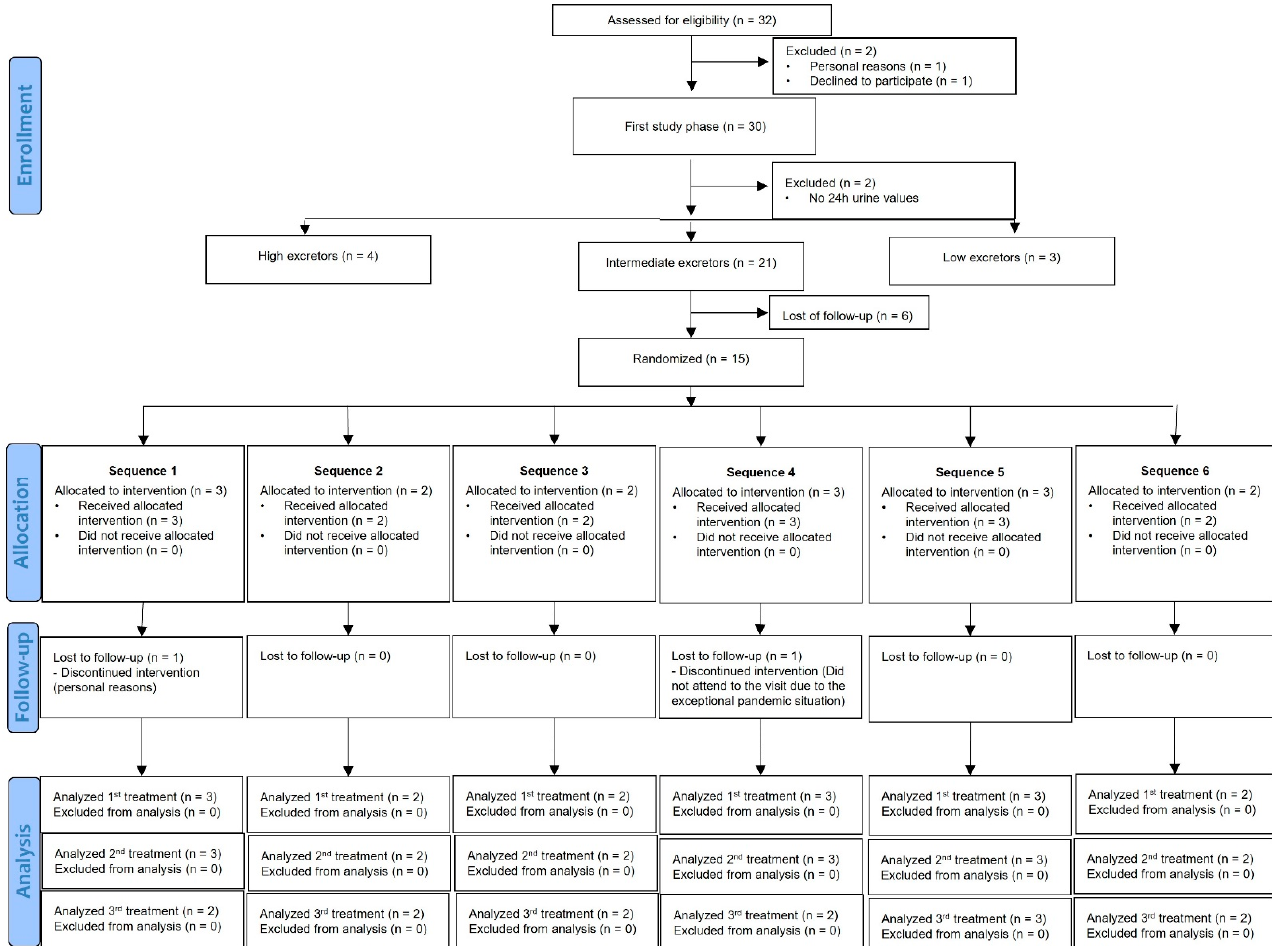
Figure 2. Participant flowchart. Sequence 1: Hesperidin epimeric mixture (HEM), micronized Hesperidin epimeric mixture (MHEM), micronized 2S-Hesperidin (M2SH); Sequence 2: HEM, M2SH, MHEM; Sequence 3: MHEM, HEM, M2SH; Sequence 4: MHEM, M2SH, HEM; Sequence 5: M2SH, HEM, MHEM; Sequence 6: M2SH, MHEM, HEM.